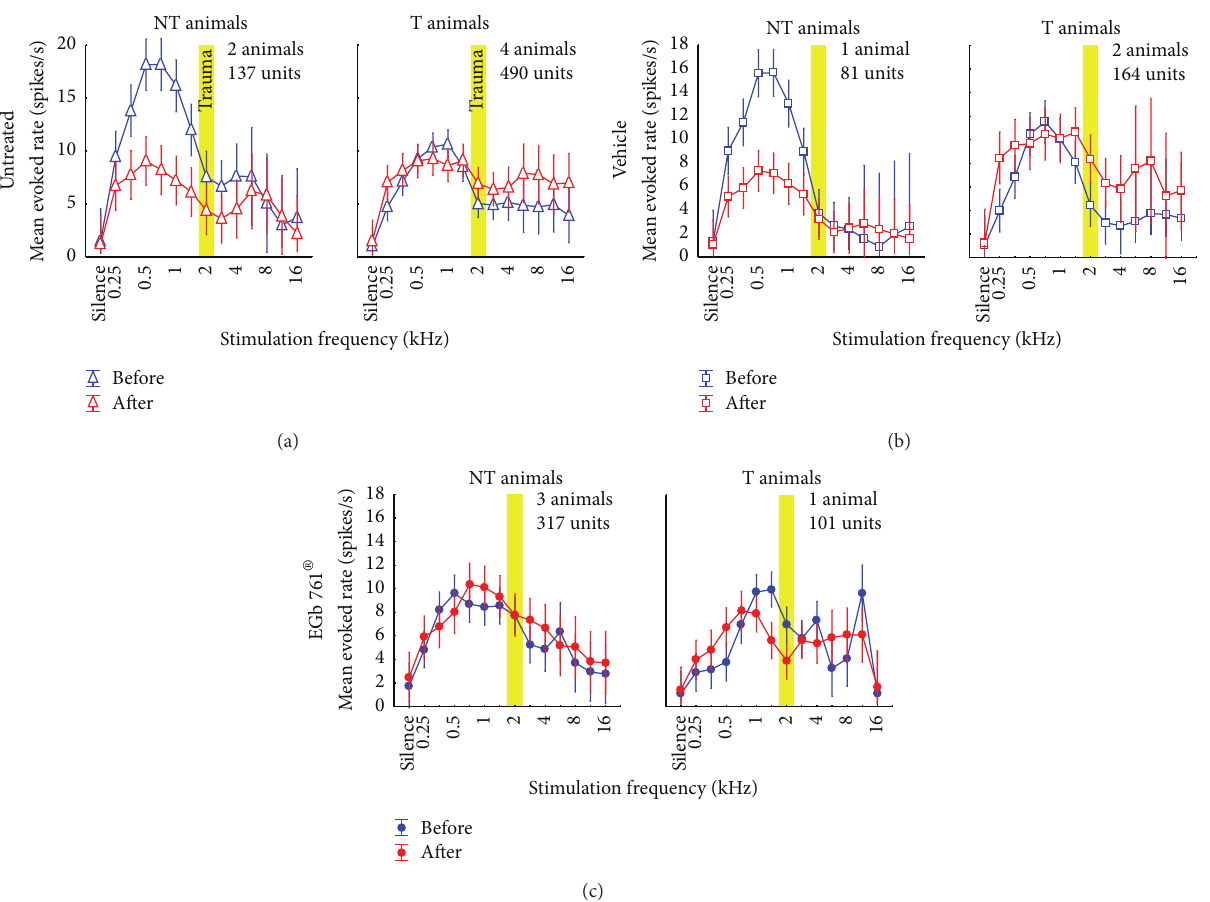
Figure 7: Mean evoked neuronal response ( ± 95% confidence interval) to iso-intensity pure tone stimulation across all recorded units in non-tinnitus and tinnitus perceiving animals. Animals that did not develop a tinnitus percept are grouped in the left column while animals that perceived tinnitus are shown in the right column. Depicted are the mean evoked rates (spikes/s) before (blue) and after (red) acoustic trauma at 2 kHz (yellow bar). (a) Data from untreated animals replotted from an earlier study [31]. 2-factorial ANOVA interaction 𝐹 statistics: NT: 𝐹(13,1866) = 3.12 , 𝑃 < 0.001 ; T: 𝐹(13,5952) = 1.54 , 𝑃 = 0.10 . (b) Data from vehicle treated animals. 2-factorial ANOVA interaction 𝐹